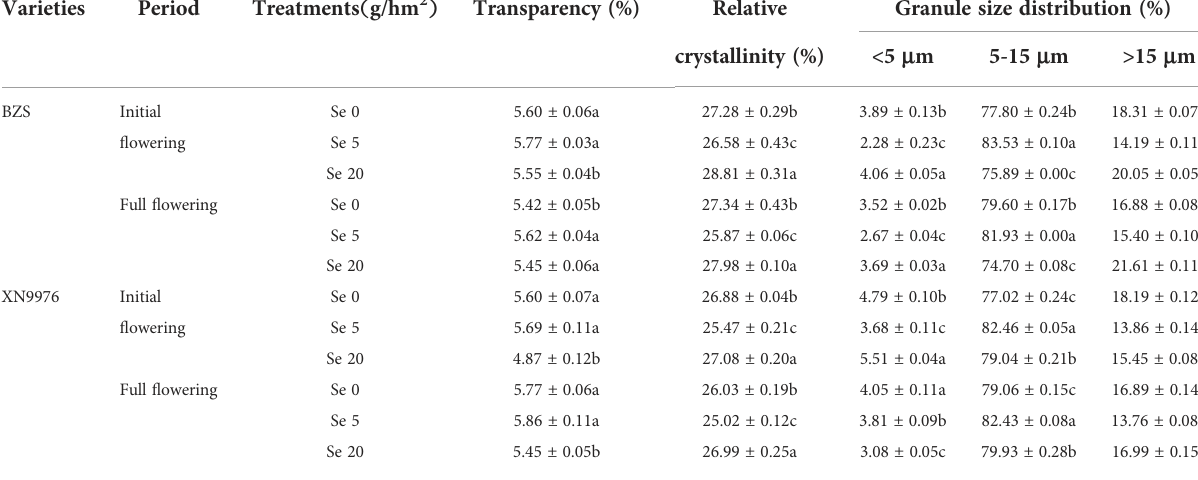
TABLE 1 Transparency, relative crystallinity and granule size distribution of common buckwheat under different selenium treatment level. Varieties